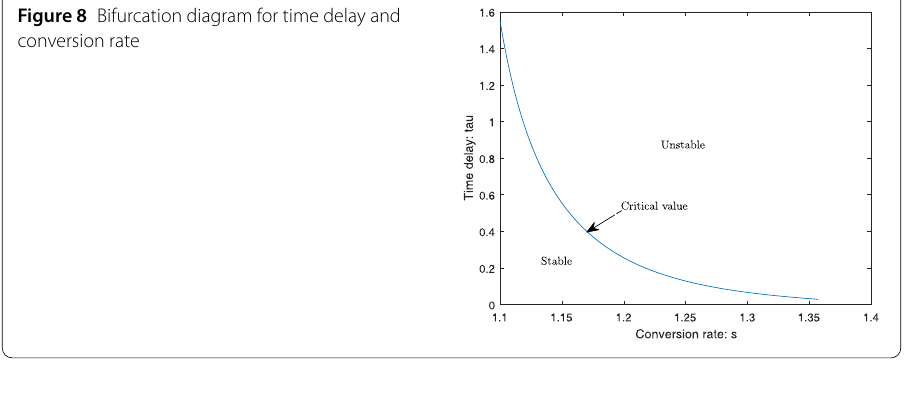
Figure 9 Bifurcation diagram for time delay and half-saturation